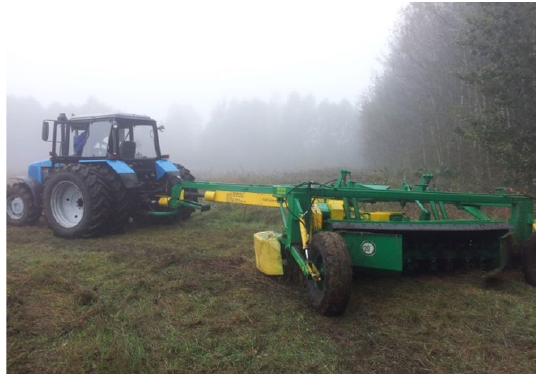
Fig. 1. Twin wheels tractor MTZ-952 with a trailed rotary mower KDP-310 in the